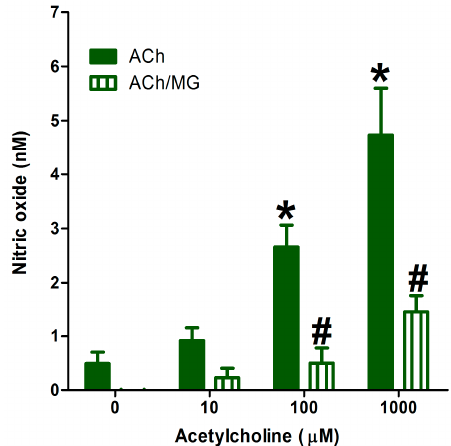
Figure 5. Effect of the addition of cumulative concentrations of ACh on nitric oxide generation from isolated normal aortae or aortae preincubated for 1 h with 400 µM methyl glyoxal (MG). Values shown represent the mean ± SEM for four independent replicate experiments. * Significantly different from NO generation before ACh addition at p < 0.05. # Significantly different from NO generation at the corresponding ACh concentration at p < 0.05 by two-way ANOVA followed by Bonferroni post hoc test.